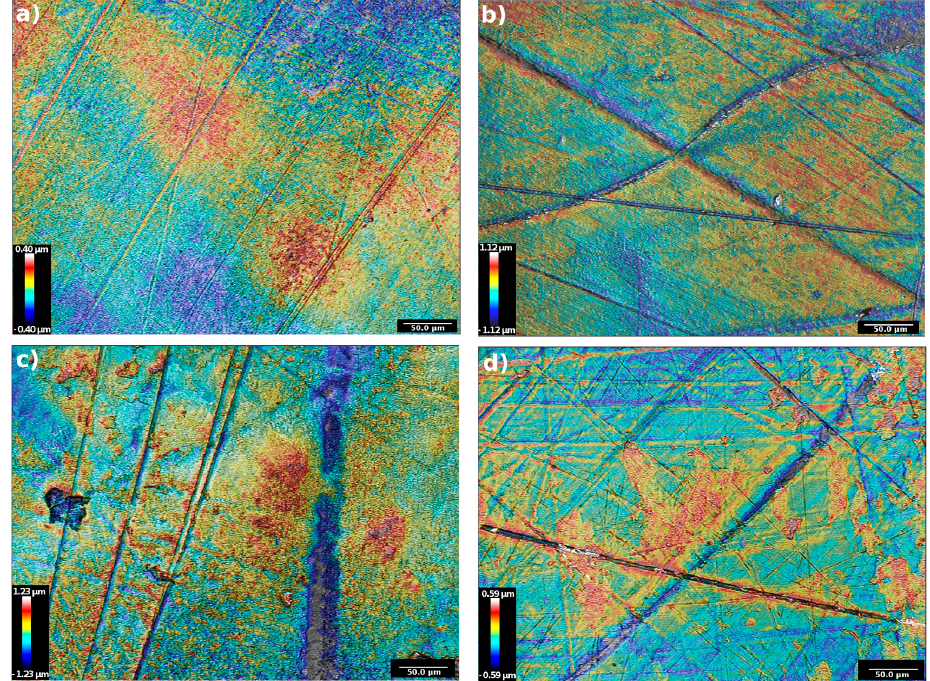
Figure 4. First set of contour images of the topographies acquired on the worn inner surfaces of four loaded specimens: ( a ) VE; ( b ) STD; ( c ) XL-75; ( d ) XL-50.